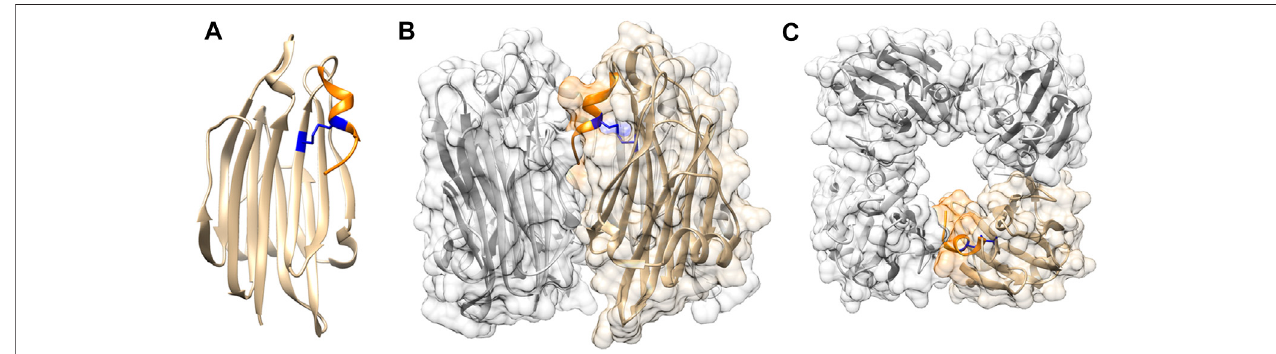
FIGURE 1 | Structural features of TDH (A) TDH protomer adopts a core β -sandwich domain. C-terminal region (shown in orange) is attached to the core domain throughintra-protomerdisulphidelinkage(showninblue) (B) SideviewoftetramericassemblyofTDH.OneoftheprotomersishighlightedincolourasreferredinpanelA (C) Top view of the TDH tetrameric assembly showing the central pore. Structural models of TDH were generated with UCSF Chimera using the structural coordinate obtained from the protein data bank (PDB; PDB ID